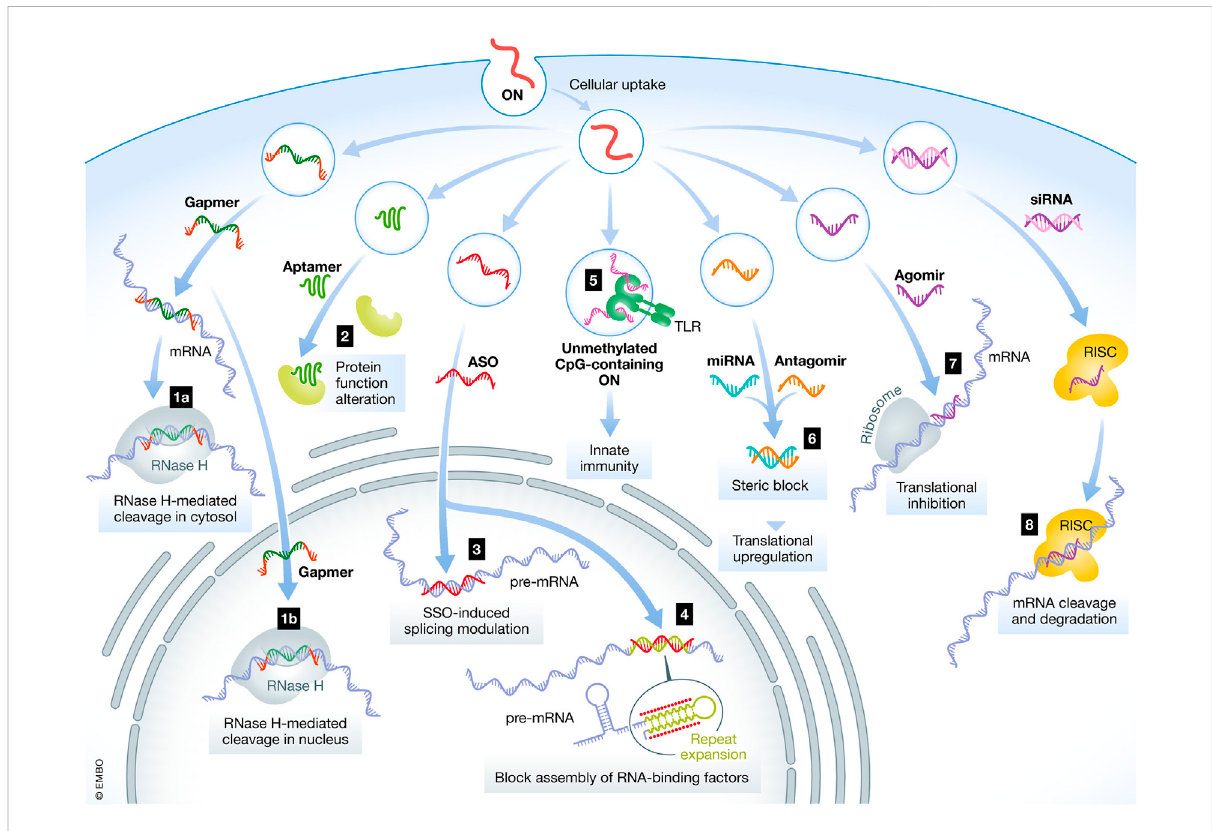
FIGURE 4 Mechanisms and location of action for various oligonucleotides. ON- Oligonucleotides, ASO- Antisense oligonucleotides, siRNA — small interfering RNA, mRNA- messenger RNA, miRNA – microRNA (Hammond et al., 2021 under Creative Commons Attribution License CC-